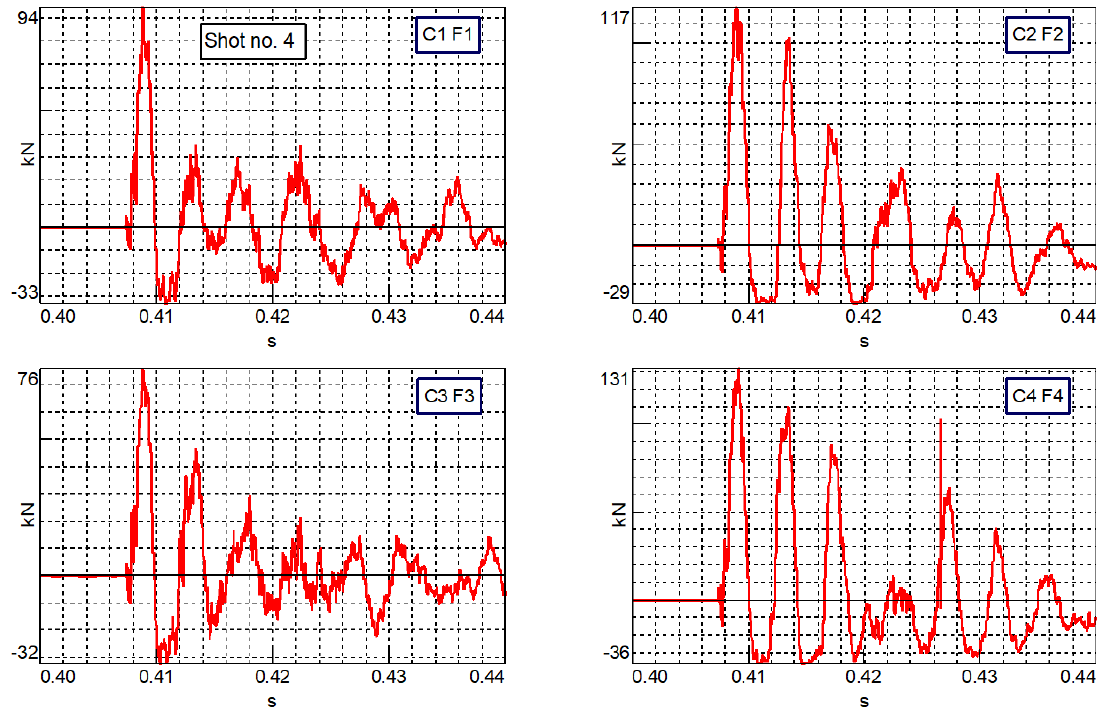
Figure 15. Forces recorded by 4 load sensors (shot no. 4).